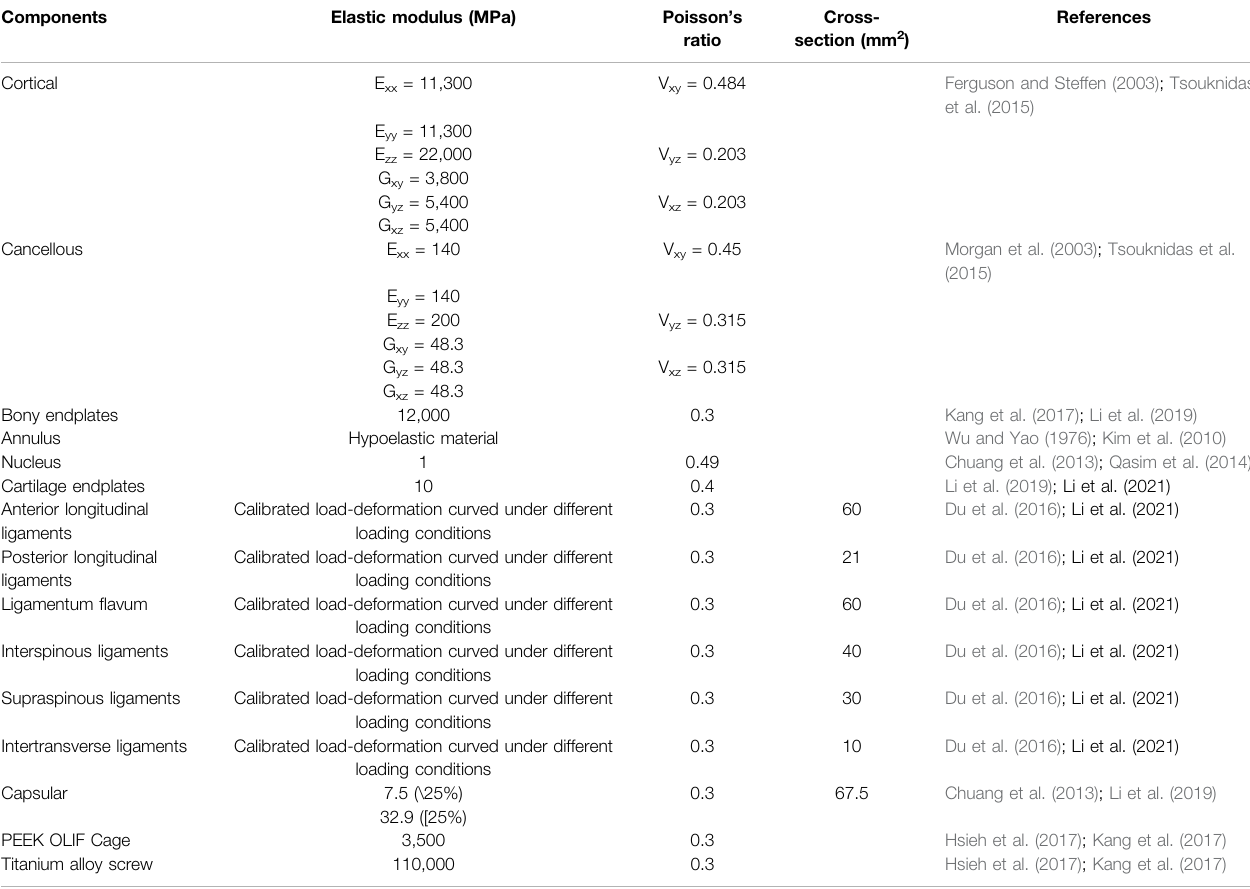
TABLE 2 | Material properties of FE models ’ components.